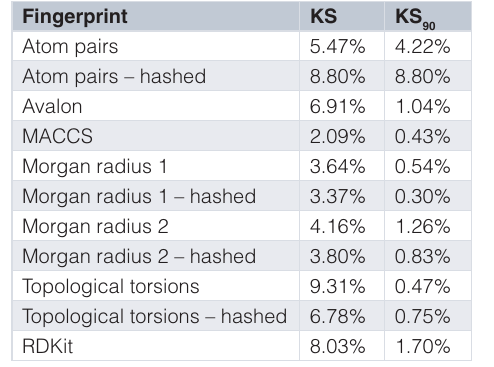
Table 2. Kolmogorov-Smirnov statistics.